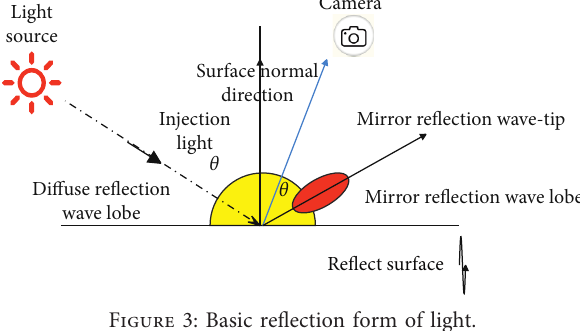
Figure 1: Schematic diagram of strong reflective surface.